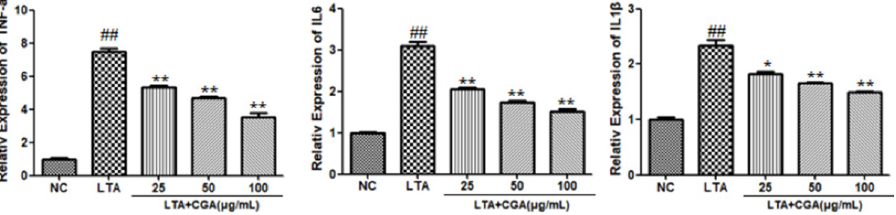
Fig 3. Effect of chlorogenic acid (CGA) on lipoteichoic acid (LTA)-induced gene expression of inflammatory cytokines. The values presented are the mean ± SE of three independent experiments. ## p < 0.01 vs. control group; � p < 0.05, �� p < 0.01 vs. LTA group. NC: normal control; LTA: lipoteichoic acid; LTA+CGA: lipoteichoic acid and chlorogenic